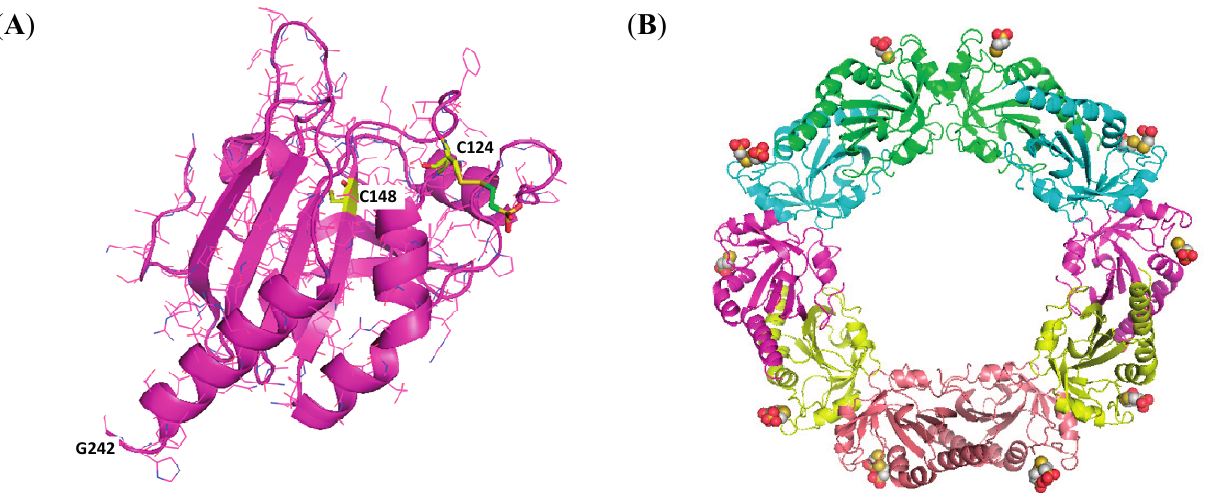
Figure 5. Ammonium sulfate condition crystals (1.6 M ammonium sulfate, 0.1 M MES